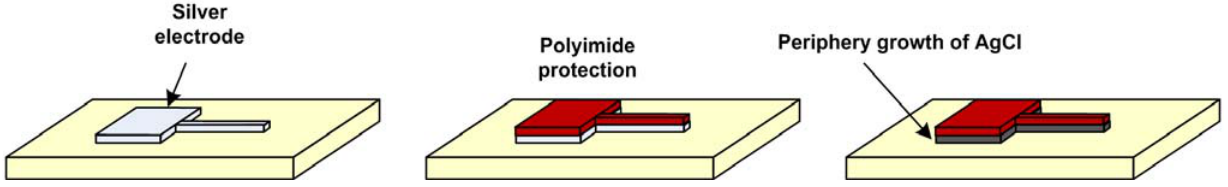
Figure 9. Bulk micromachined reference electrode channel and membrane [64].